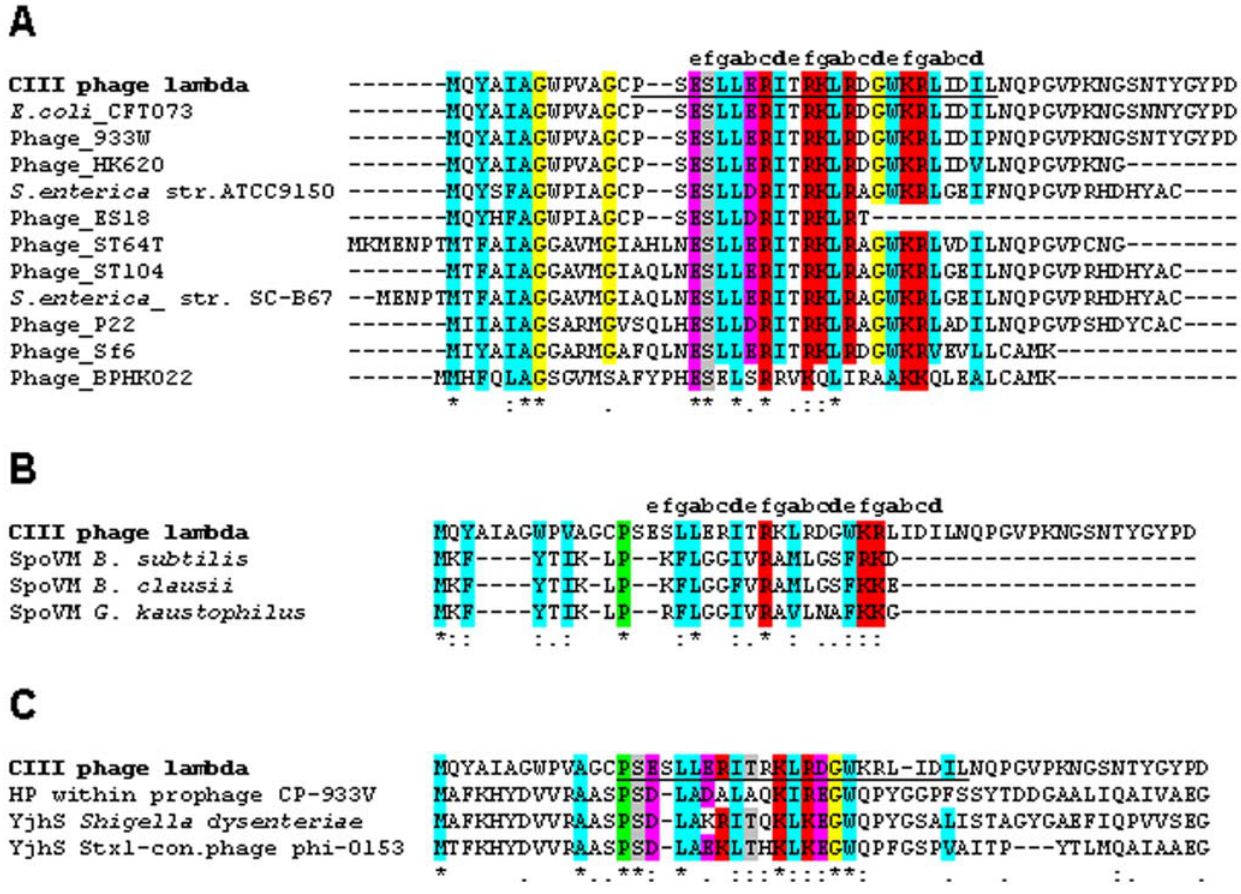
Figure 1. Conservation of CIII in phage and bacteria. The multi sequences alignment was done using the ClustalX (version 1.81) program. Conserved or partially conserved residues are colored according to their biochemical properties. The essential region for CIII activity is underlined and the positions predicted coiled coil (by the MARCOIL) is marked above the sequence. (A) Alignment of CIII proteins from different phages and prophages (represented by the phage name or the bacterial strain carrying the prophage, respectively). CIII proteins were collected from the BLAST program by using the lambda CIII sequence as a query for the non-redundant database. A separate search using the HK022 CIII sequence was done. The HK022 CIII sequence is identical to that of HK097A and H-19B. A complete list of all the phages and prophages in which CIII homologs were recognized, is presented in the supplementary material. (B) Alignment of CIII and SpoVM proteins was carried out with the lambda CIII protein aligned with three SpoVM proteins from different Bacillus strains. (C) Alignment of CIII and YjhS hypothetical proteins that carry the DUF1737 and DUF303, was carried out. The three YjhS-like proteins were derived from different Shigella toxin carrying phages. The HP stands for hypothetical protein without a specific